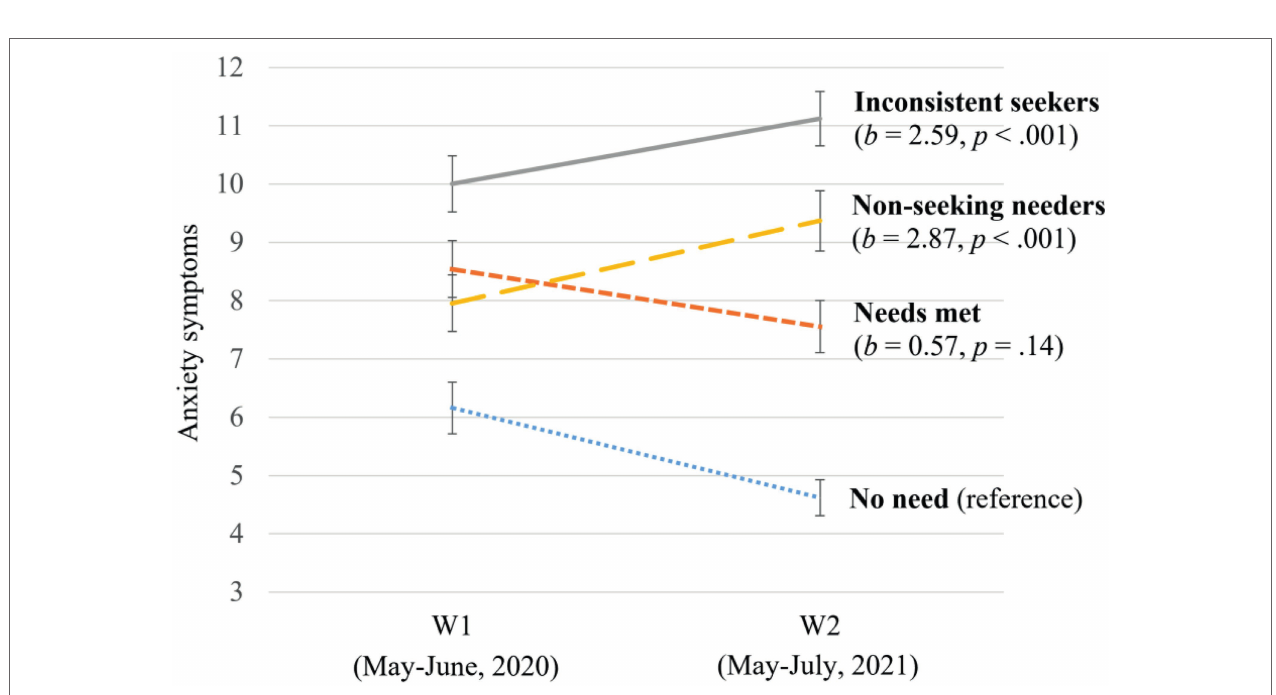
FIGURE 2 | Changes in parents’ anxiety symptoms between waves by help-seeking group. The coefficient ( b s) and corresponding p values indicate how the changes in anxiety symptoms in the three groups differed from the reference group after controlling for covariates. The error bars indicate 95% CIs of symptom levels.